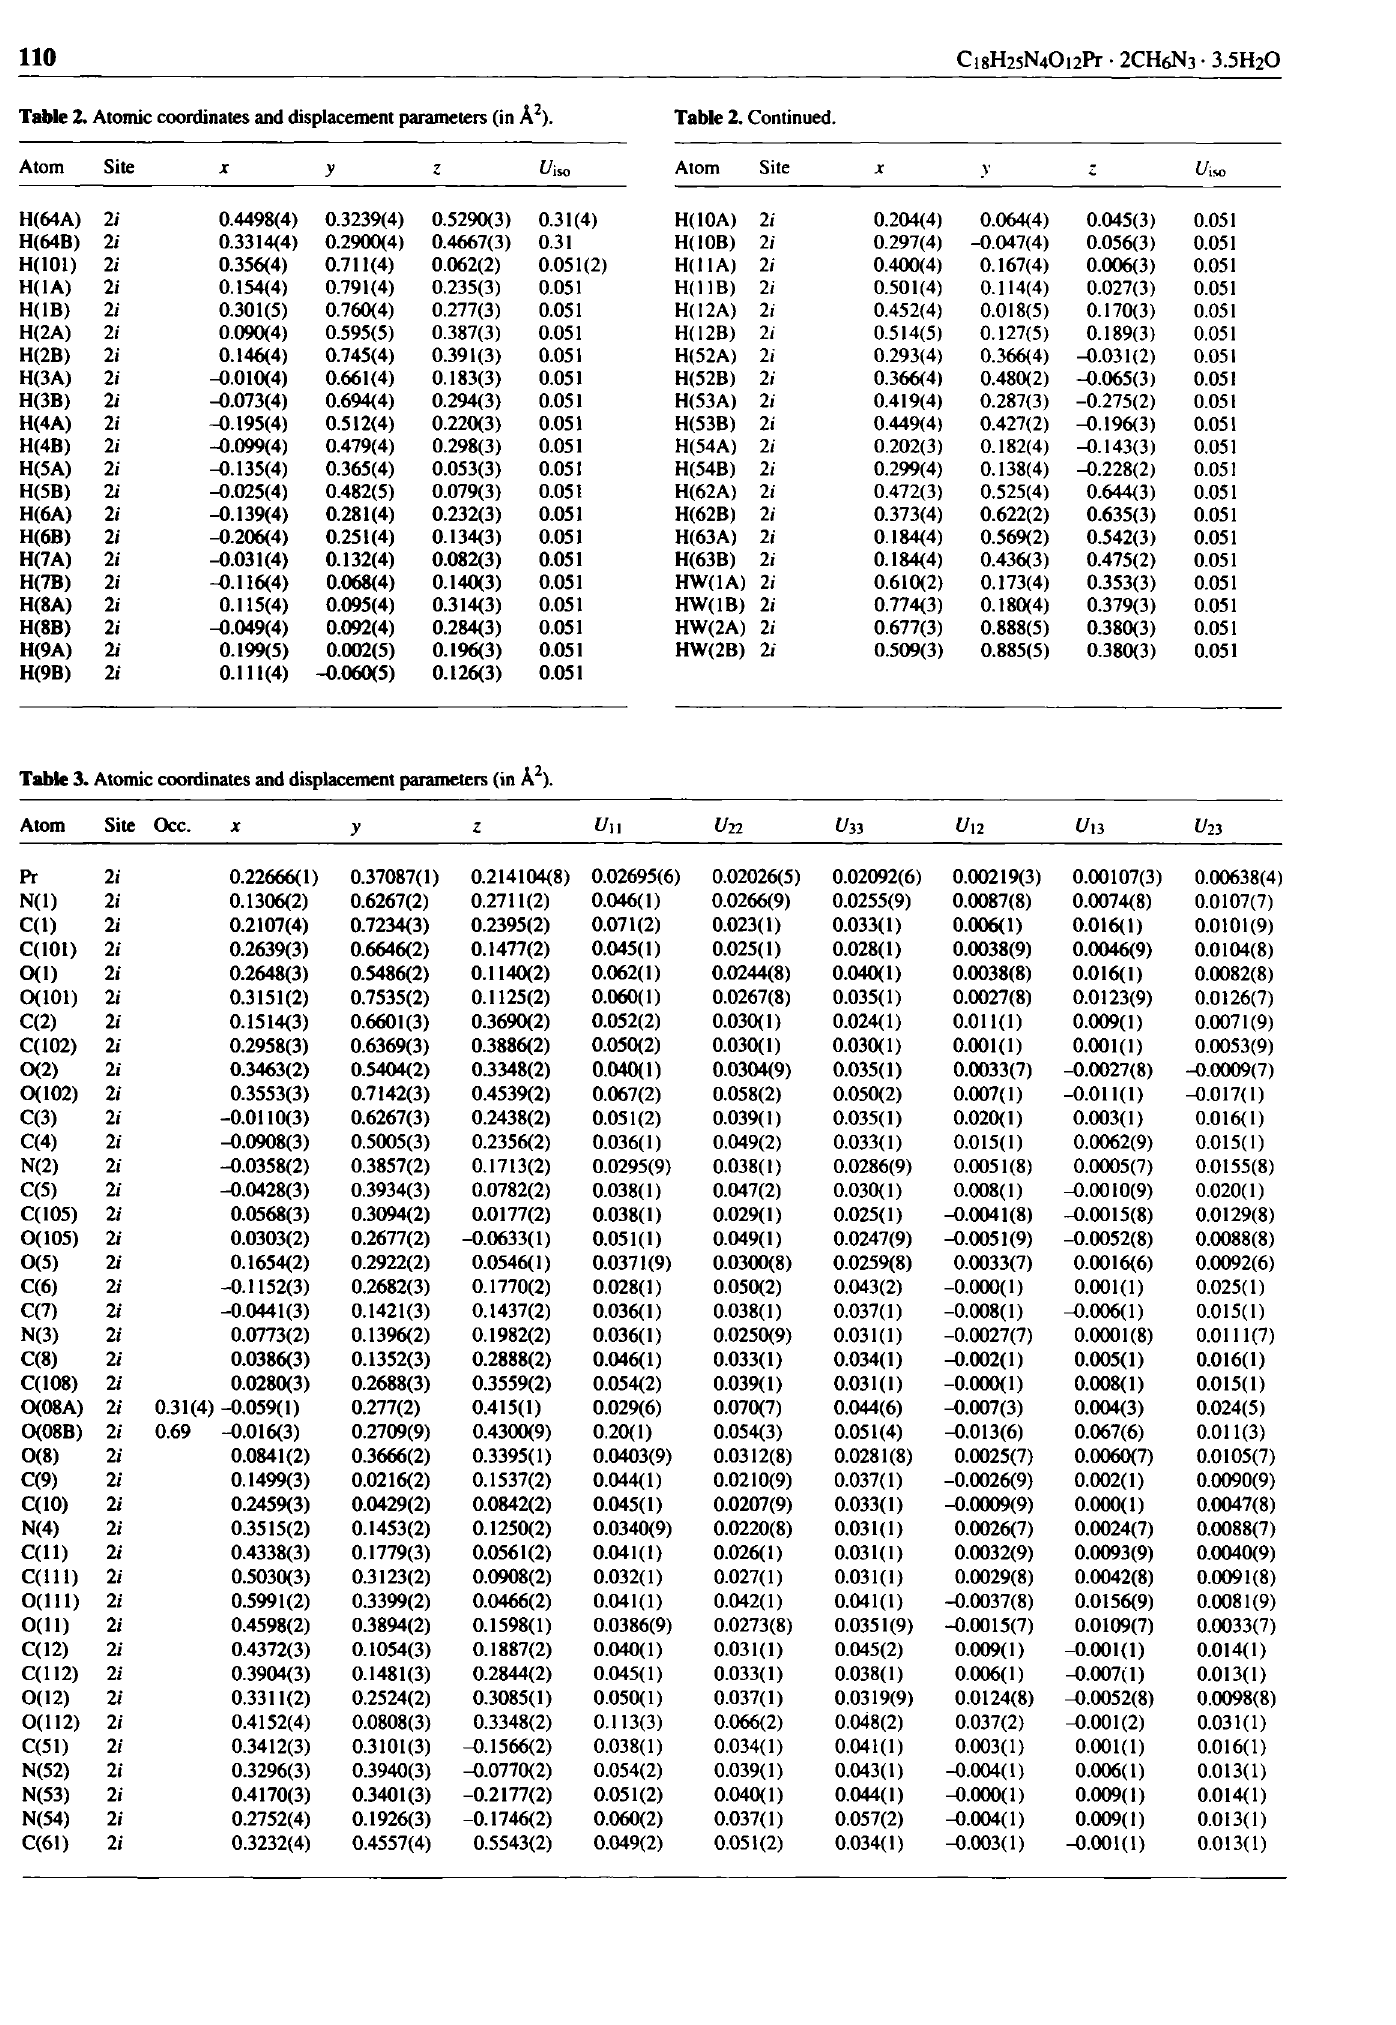
Table 3. Atomic coordinates and displacement parameters (in À 2